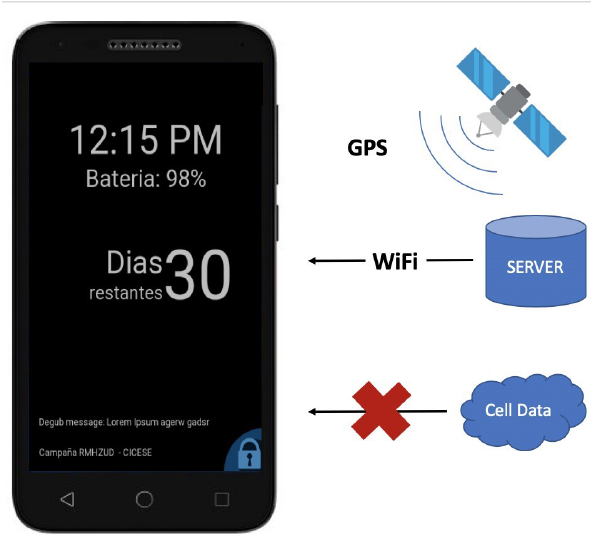
Figure 2. During the crowd-sensing campaign, phones do not have access to a data network and run in non-interactive